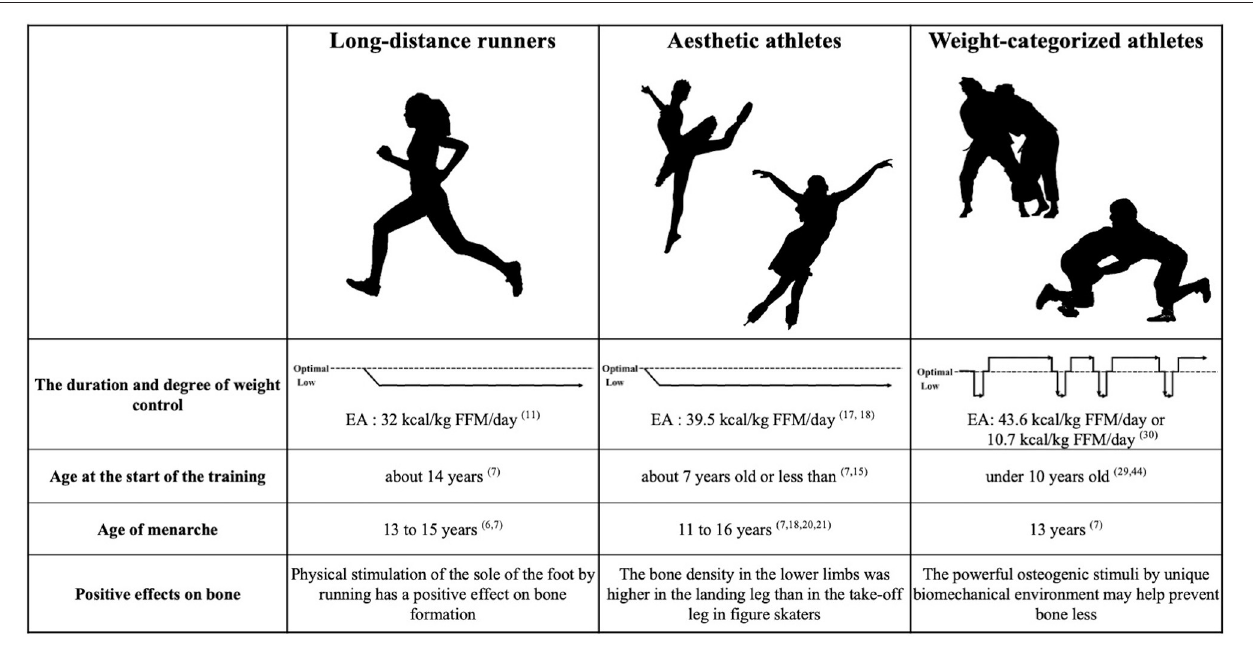
FIGURE 1 | Conceptual diagram of the duration and degree of weight control and the characteristics of each sport. Numbers indicate reference